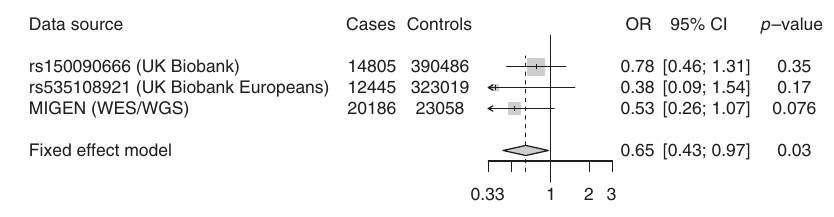
Fig. 5 Association of predicted loss-of-function variants in PDE3B with coronary artery disease. Estimates were derived in UK Biobank using logistic regression, adjusted for age, sex, ten principal components of ancestry, and array type. Estimates were derived in MIGEN (Myocardial Infarction Genetics Consortium) using logistic regression, adjusted for sex and fi ve principal components of